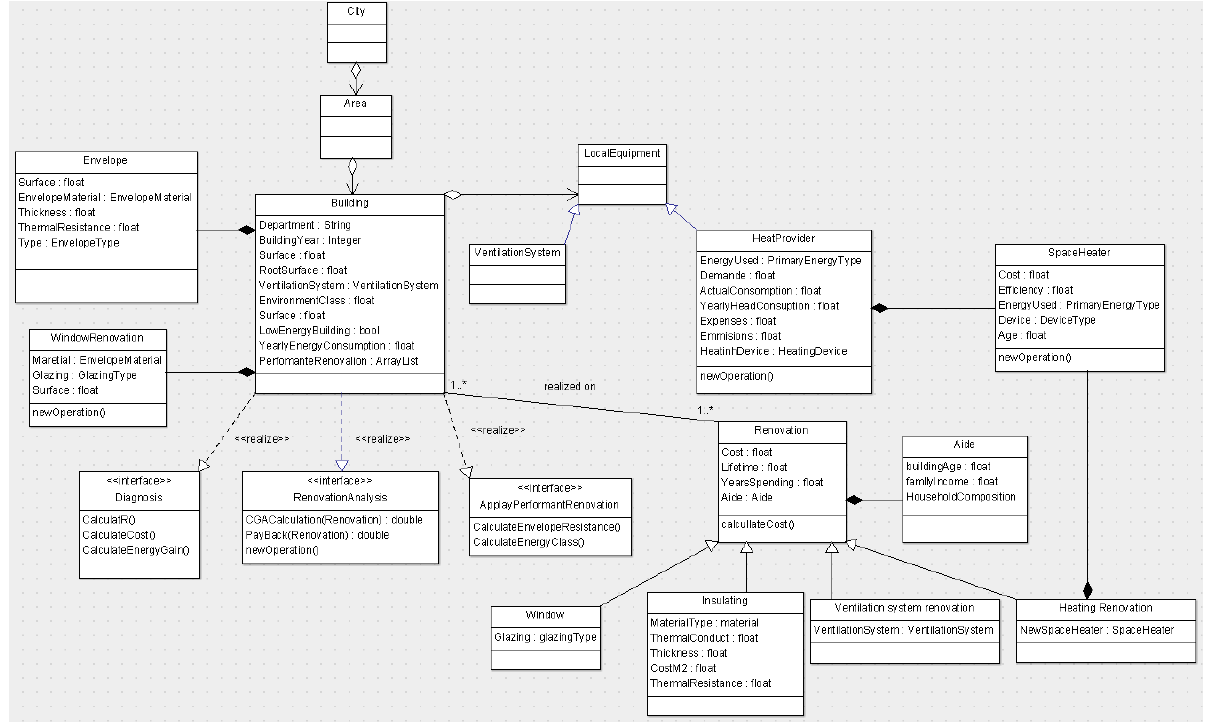
Figure 5. UML diagram of our energy renovation